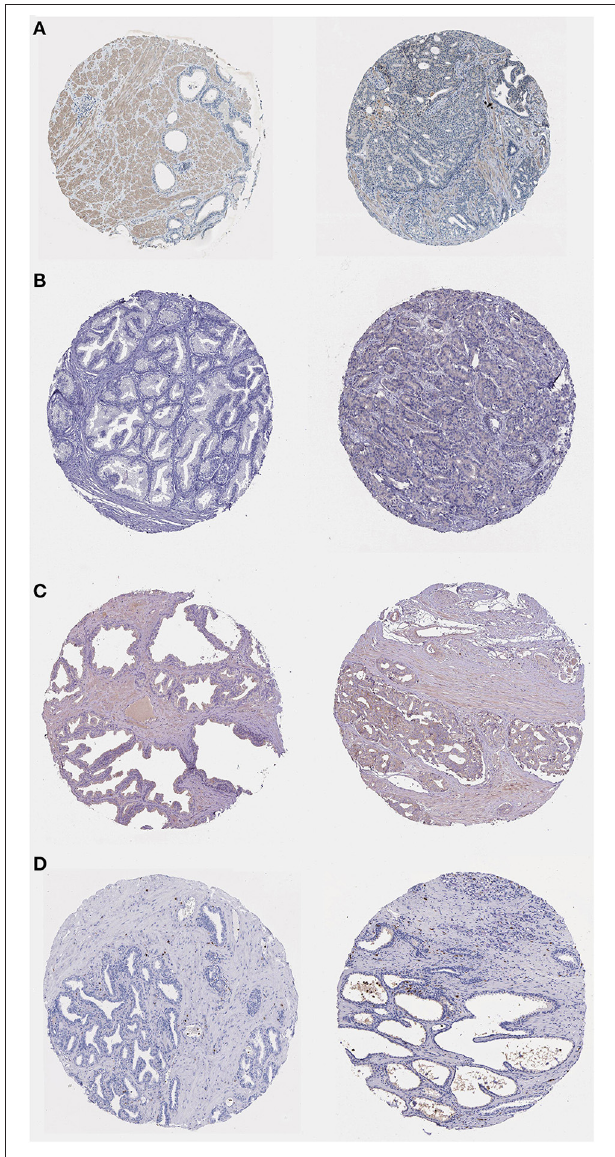
FIGURE 13 | Immunohistochemistry of bone metastasis-associated prognostic genes in normal prostate tissue (left) and PRAD (right) samples. (A) Immunohistochemistry of DDX47 in normal prostate tissue (left) and PRAD (right). Patient information: normal (patient id: 2,053, male, age 51); PRAD (patient id: 3,571, male, age 71). (B) Immunohistochemistry of AS3MT in normal prostate tissue (left) and PRAD (right) samples. Patient information: normal (patient id: 3,376, male, age 72); PRAD (patient id: 5,412, male, age 63). (C) Immunohistochemistry of ISLR in normal prostate tissue (left) and PRAD (right) samples. Patient information: normal (patient id: 3,497, male, age 37); PRAD (patient id: 4,365, male, age 71). (D) Immunohistochemistry of S100A8 in normal prostate tissue (left) and PRAD (right). Patient information: normal (patient id: 2,053, male, age 51); PRAD (patient id: 3,190, male, age 72)